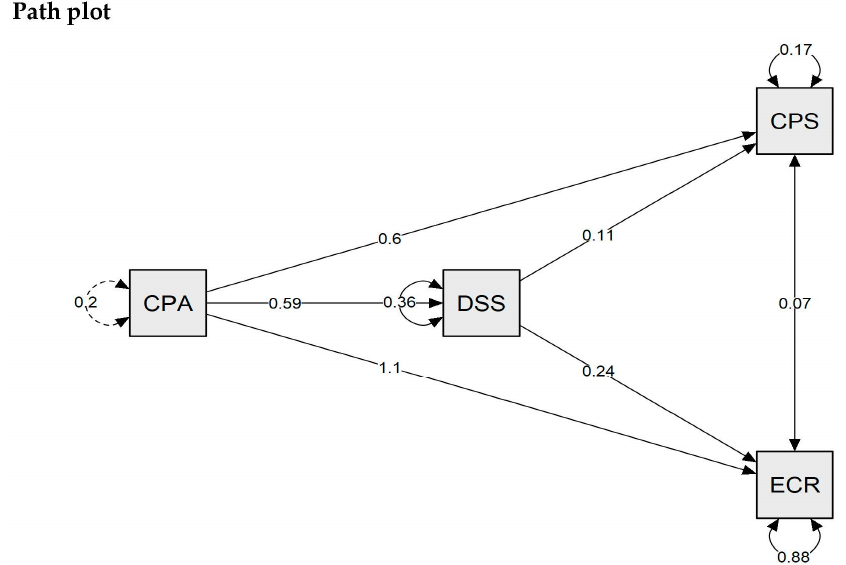
8 of 13 Figure 2. Mediation model hypothesis. Note: CPA—Positive attitude; DSS—Decentering Sport Scale; CPS—Problem solving; ERC—Cognitive Reappraisal.